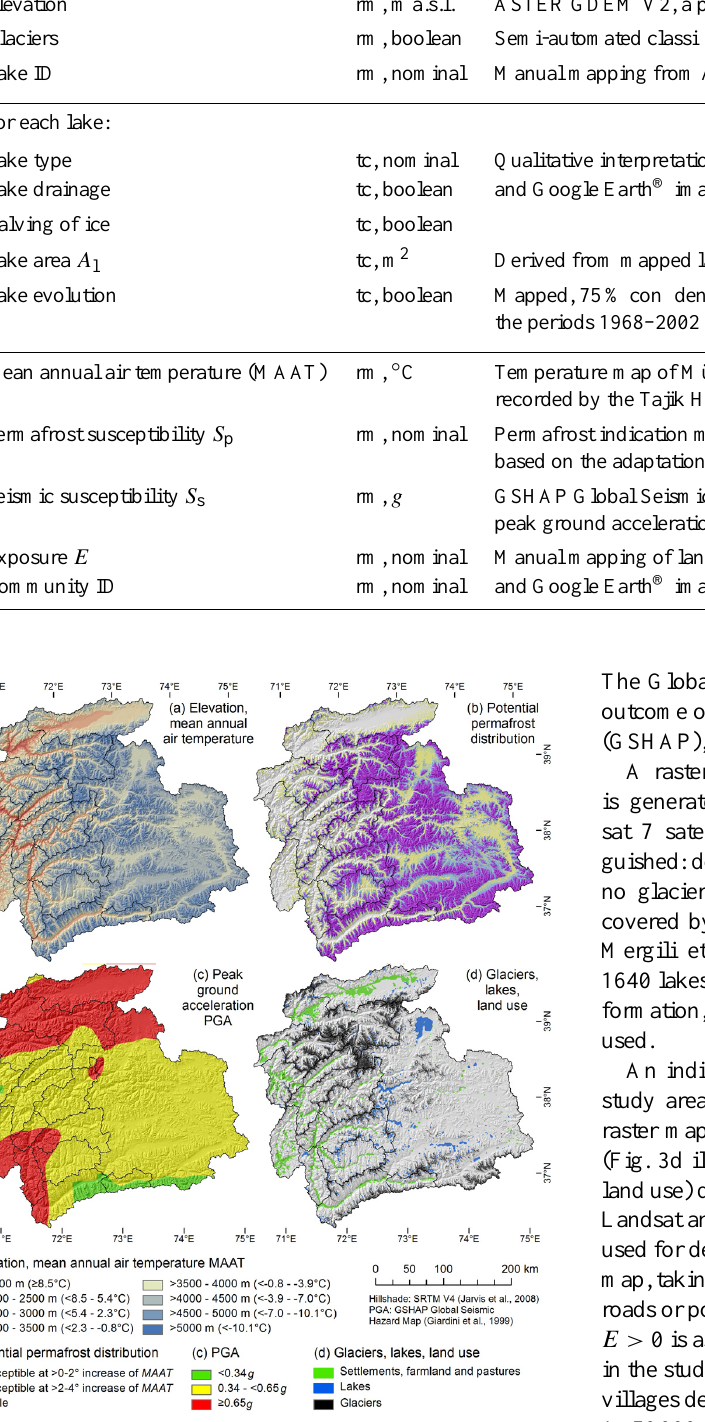
Fig. 3. Input data: (a) elevation and mean annual air temperature, (b) potential permafrost distribution, (c) peak ground acceleration, and (d) mapped glaciers, lakes and land